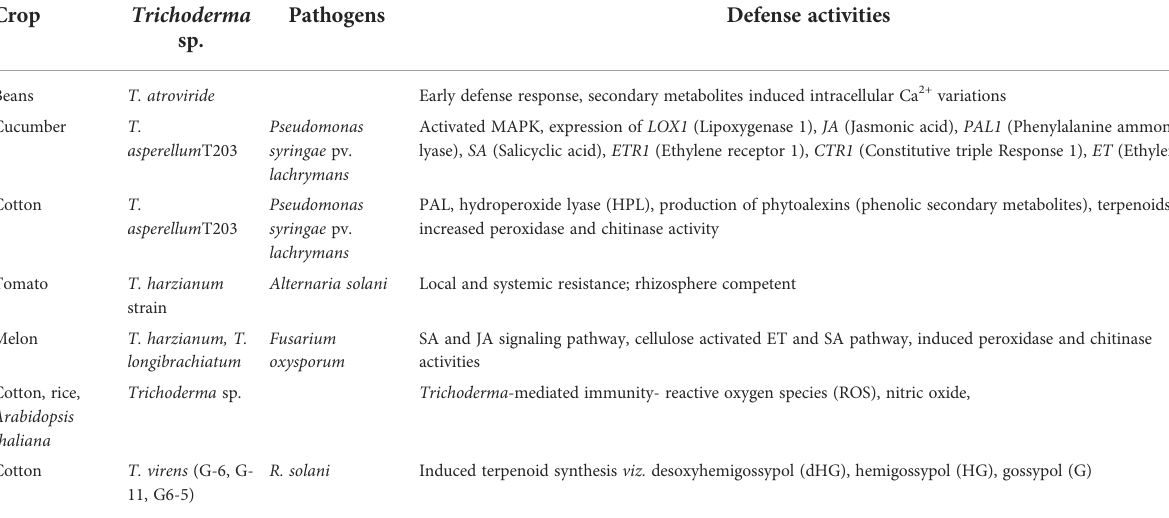
TABLE 6 Defense mechanism induced by Trichoderma spp. in various crops against different pathogens. Crop Trichoderma